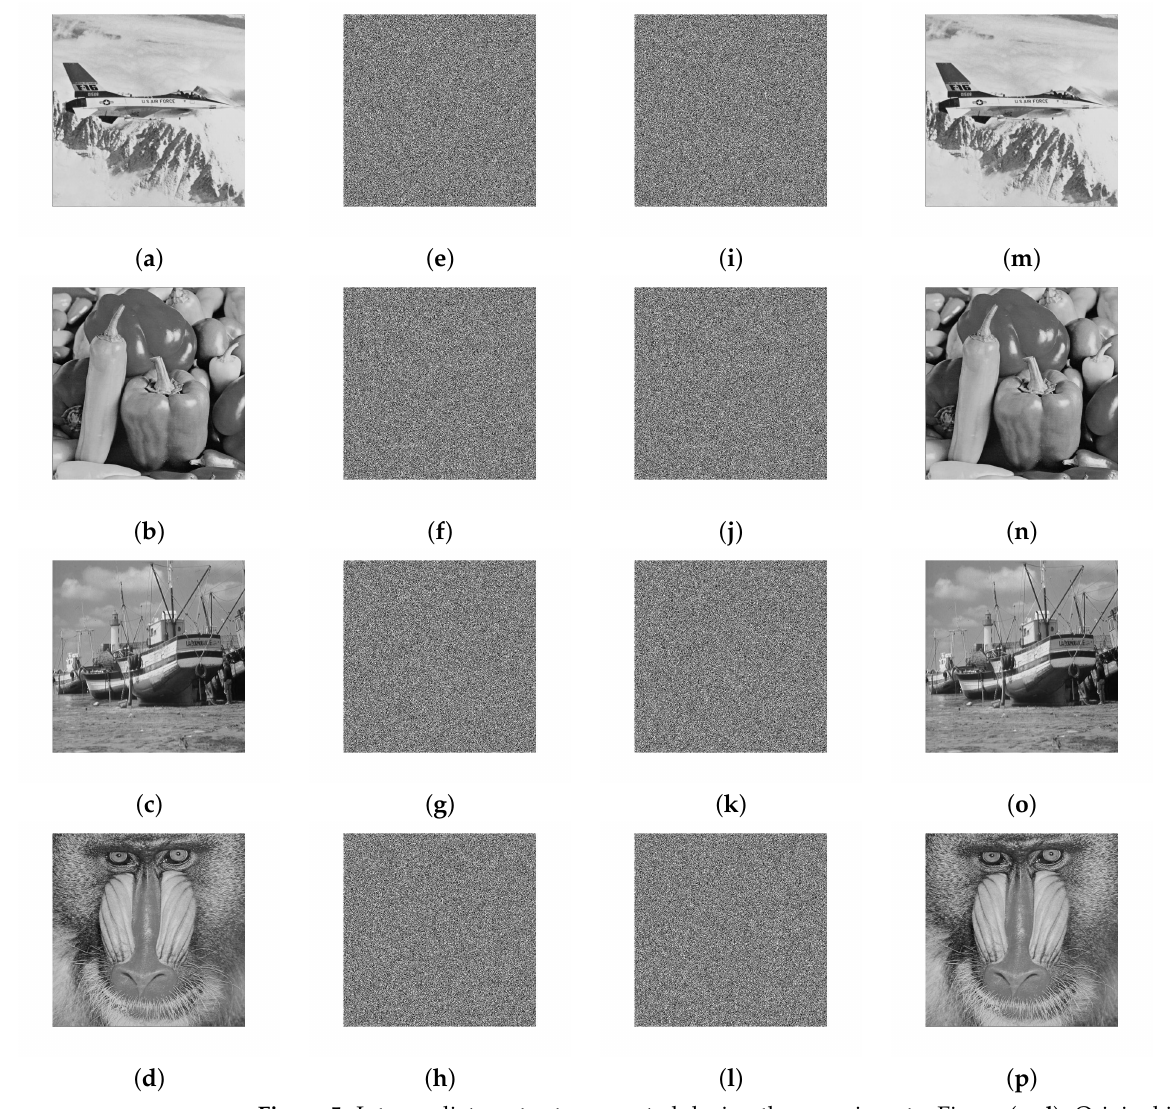
Figure 5. Intermediate outputs generated during the experiments: Figure ( a – d ): Original images, Figure ( e – h ): Encrypted images, Figure ( i – l ): Images after the embedding process, and Figure ( m – p ): Recovered